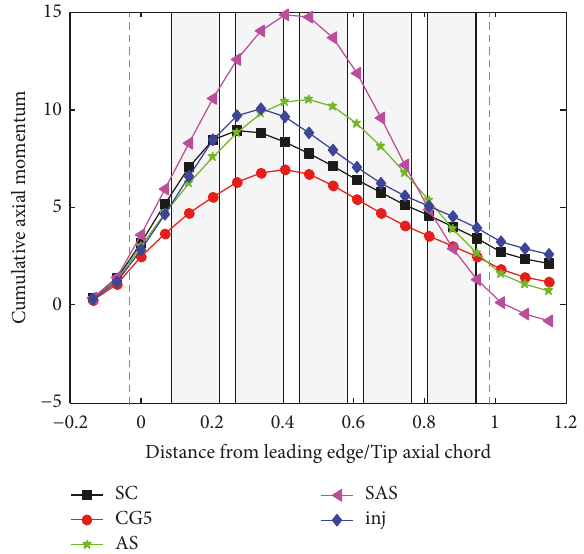
Figure 19: The bell-shaped curves for the studied casing treatments ([19]). Figure reproduced from NAN et al.